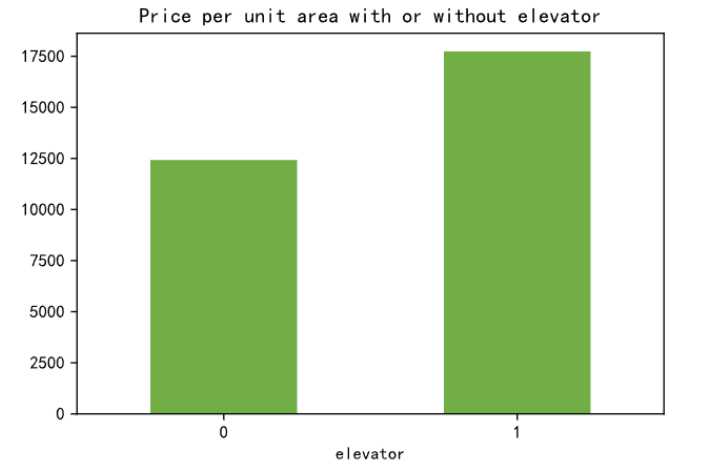
Fig. 11 Whether there are elevators affecting house